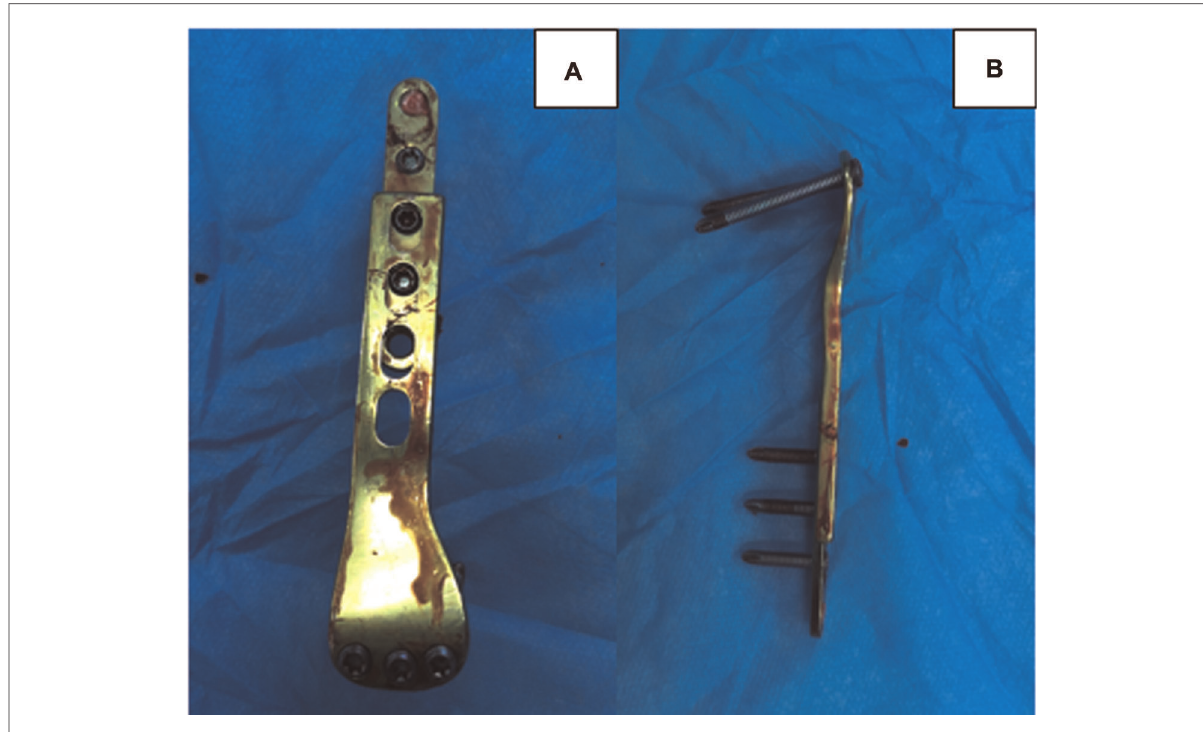
FIGURE 3 The internal fi xation device is removed completely after surgery without fracture. ( A ) The front view. ( B ) The side